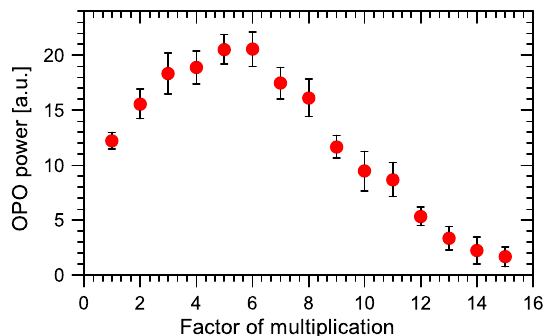
Figure 11. Oscillograms of the signal linear cavity OPO radiation at 1.53 µ m (upper trace) and 1.06 µ m pump (lower trace). ( A ) Pulse multiplication factor n = 5, time scale 5ns/div. ( B ) Pulse multiplication factor n = 15, time scale 2ns/div.